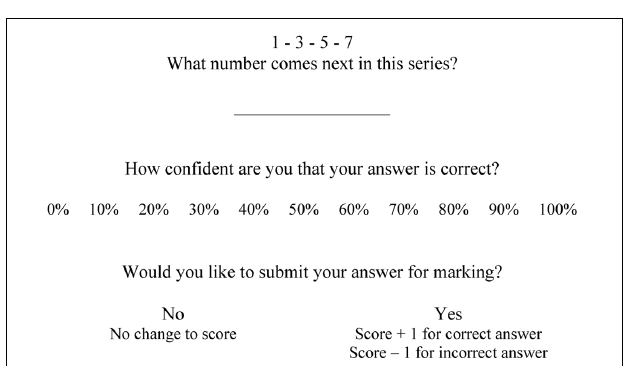
FIGURE 2 | Example item from the Number Series